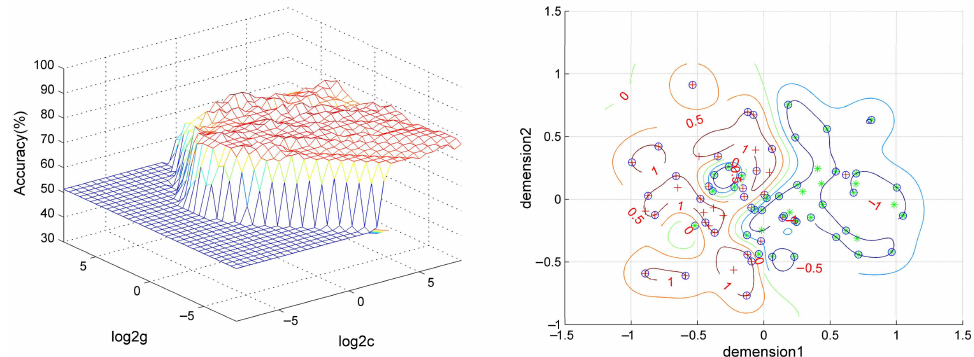
Figure 5. Visualization of SVM results using NH values of left orbitofrontal cortex and right putamen. Left: 3D visualization of SVM with the best parameters; right: classification map of the NH values of left orbitofrontal cortex and right putamen. SVM = support vector machine, NH = network homogeneity, log 2c and log 2g = the range and step size of c and g (c and g are the parameters of the kernel